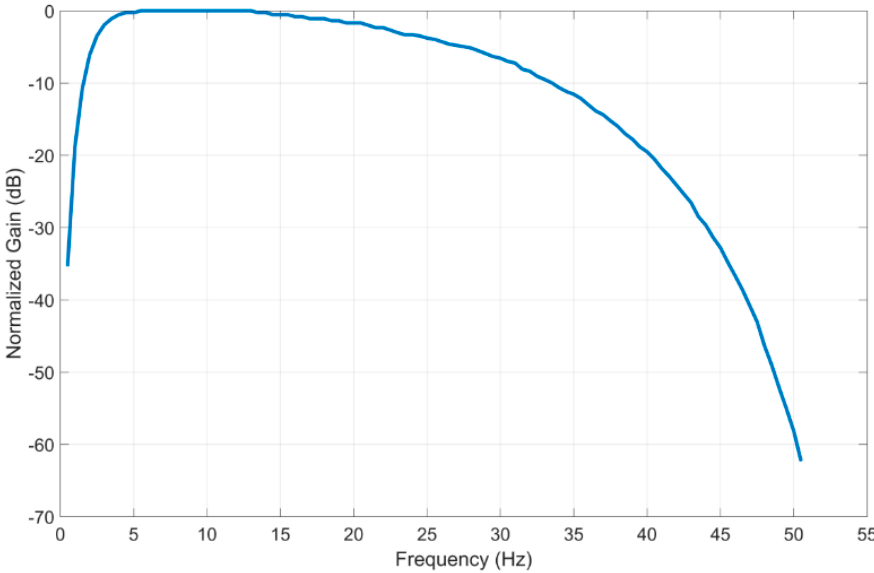
Figure 7. The experimental total frequency response of the implemented ELF detector.